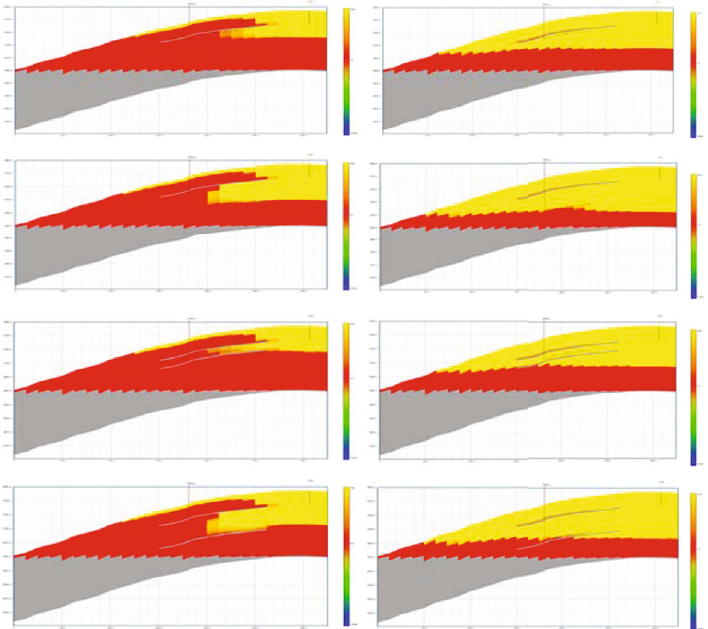
Figure 22: Variation of the gas-liquid interface in four combined relationships under vertical injection and horizontal production